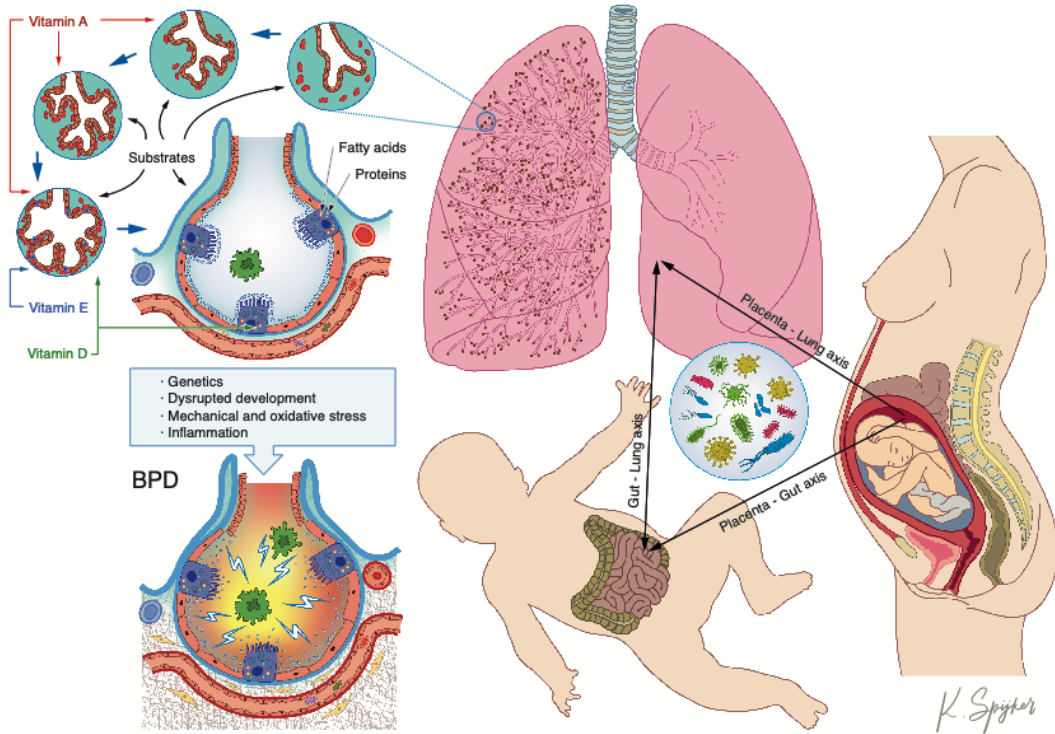
Figure 1. The placenta-gut-lung triangle. The figure illustrates the potential sources of the lung microbiome and the role of substrate supplies and specific nutrients in alveolar homeostasis, and their role in the pathway towards chronic lung disease.